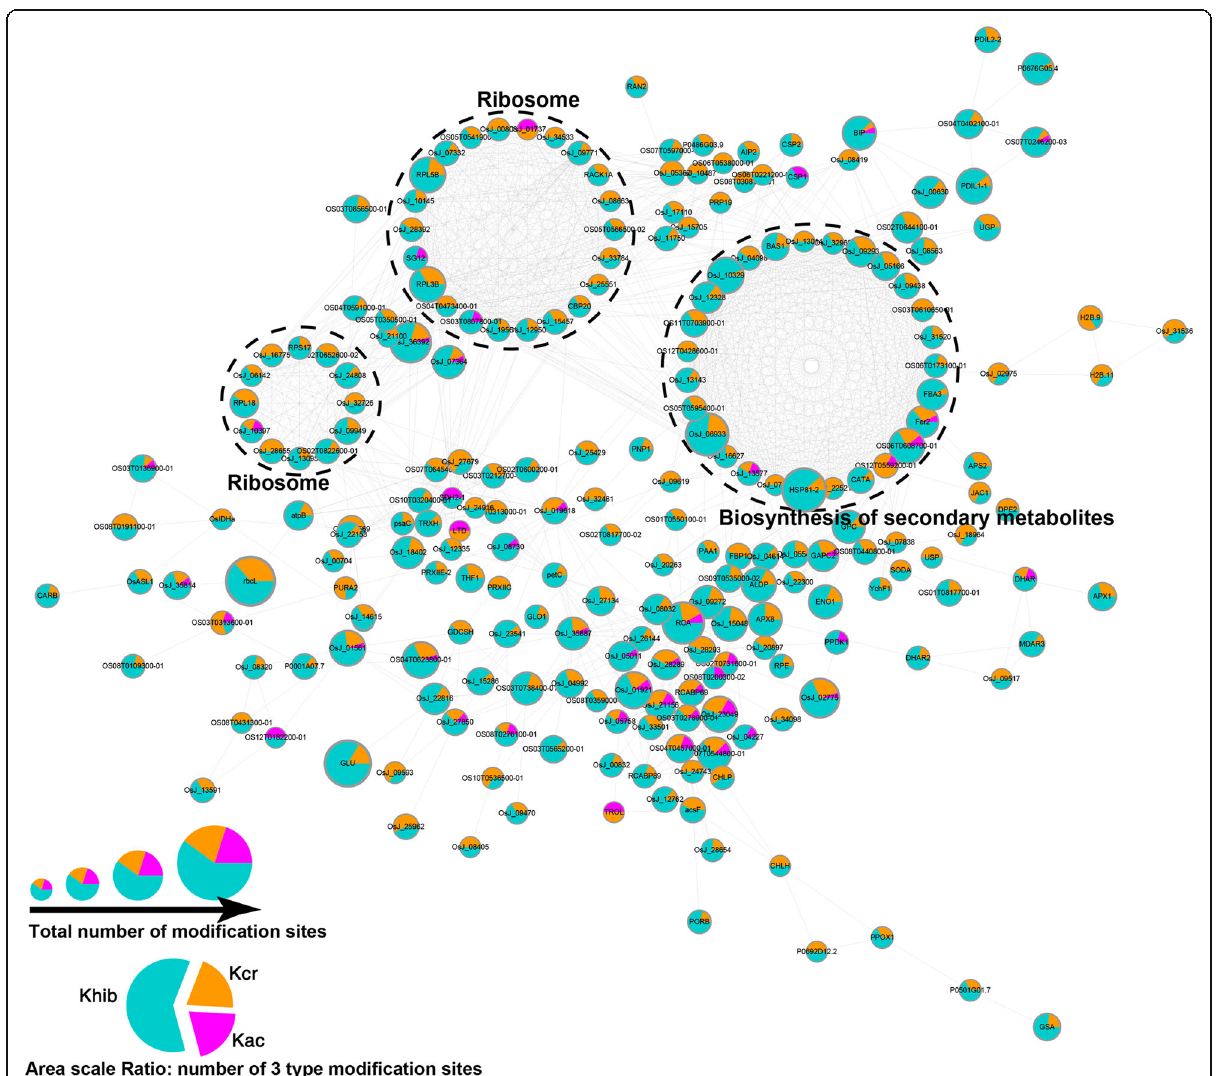
Fig. 8 The crosstalk PPI network of the overlapped proteins with Khib modification